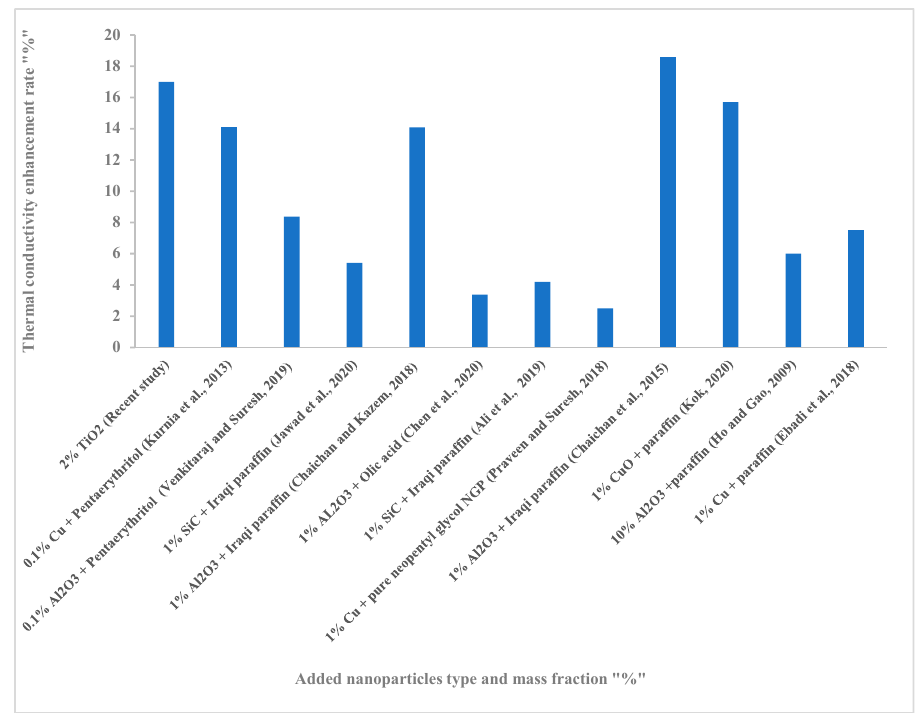
Figure 12. Comparison between the present study and other works in the literature, regarding nano-PCM TC enhancement Kurnia et al., 2013 [65]; Venkitaraj and Suresh, 2019 [66]; Jawad et al., 2020 [67]; Chaichan and Kazem, 2018 [68]; Chen et al., 2020 [44]; Ali et al., 2019 [69]; Praveen and Suresh, 2020